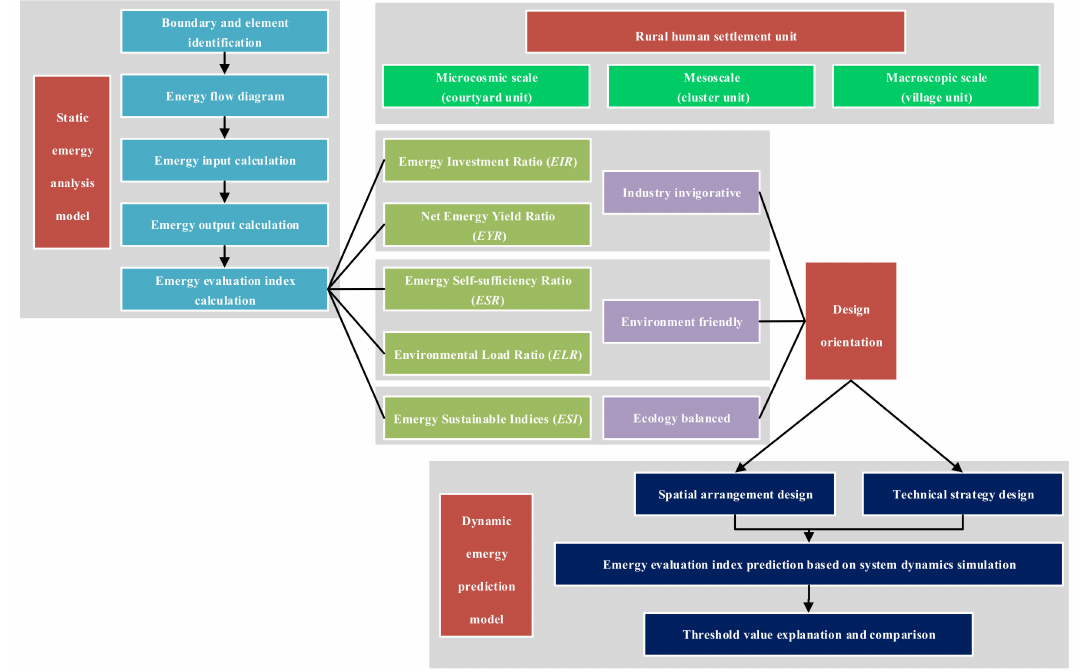
Figure 1. The technical framework of this